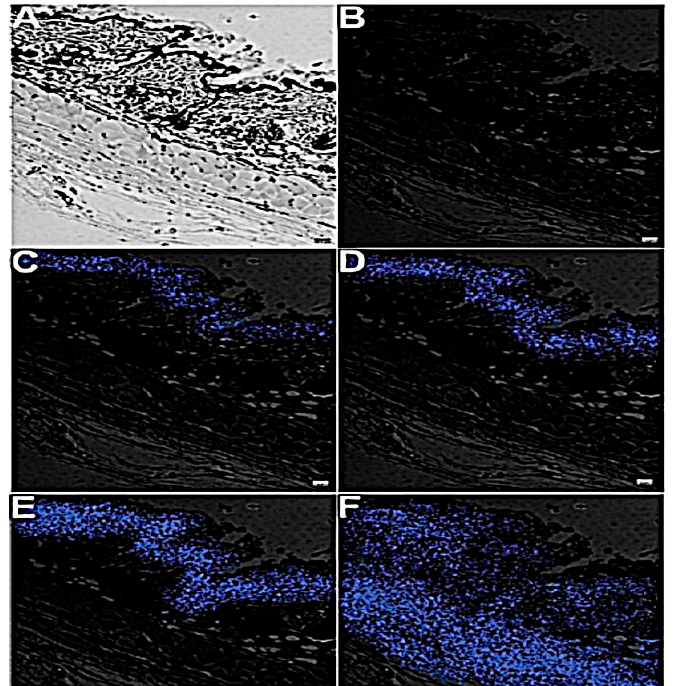
Figure 7. Images of in vivo mice skin permeation of carbon dots without R9 and carbon dots with R9 ( A ) the confocal laser microscopy images of untreated mouse skin in bright light and ( B ) fluorescent light. After two h ( C–E ) and four h ( D – F ) in mice. This image was reproduced with permission from [87]. Copyright ©, 2016, Royal Society of Chemistry. R9: peptide polyarginine. CC BY 4.0 license